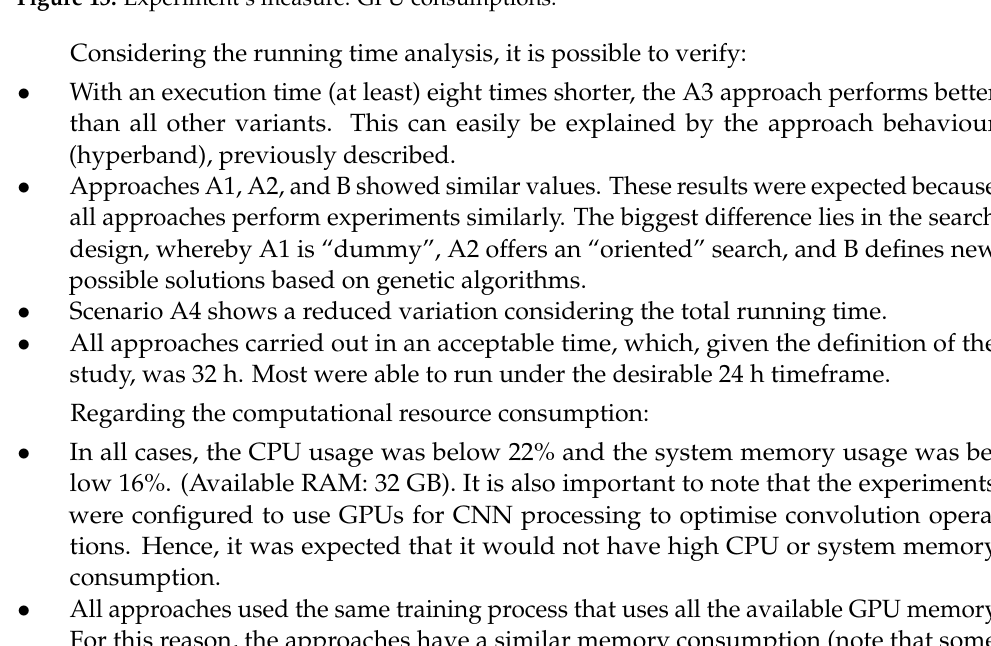
Figure 13. Experiment’s measure: GPU consumptions.